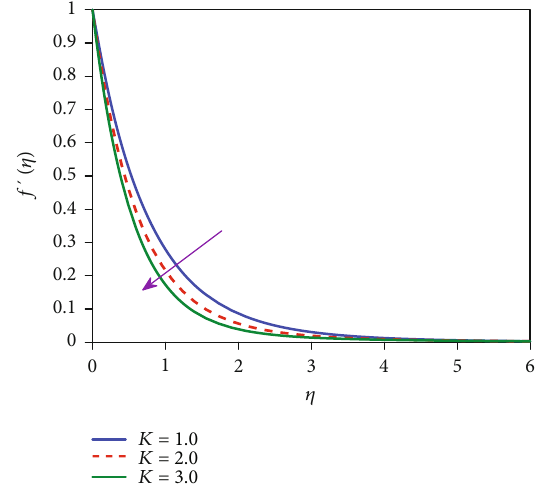
Figure 20: E ff ect of λ on the temperature θ ð η Þ .